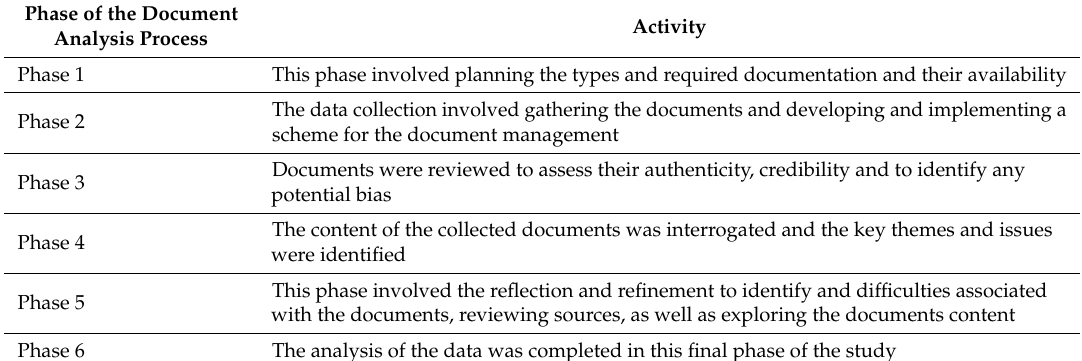
Table 1. The phases and activities undertaken in study’s document analysis process. Source: adapted from [73] (p.